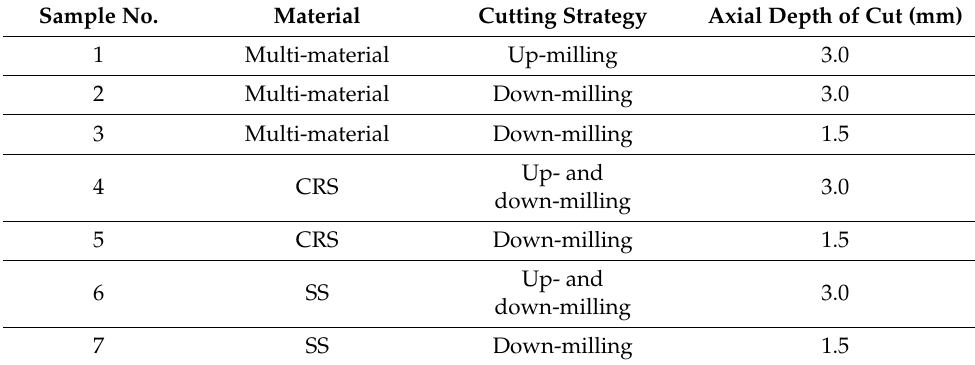
Table 5. Experimental settings used for milling.